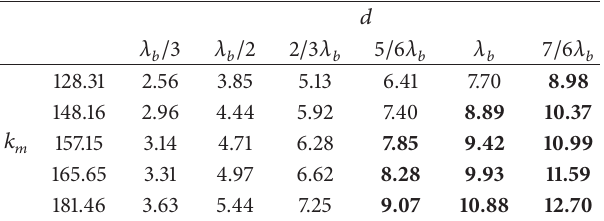
found by means of truncated SVD (TSVD) scheme, which Table 1: Values of 𝐼 for different dimensions and wavenumber of the cylindrical circular scatterers. The values corresponding to an unsatisfactory reconstruction error are